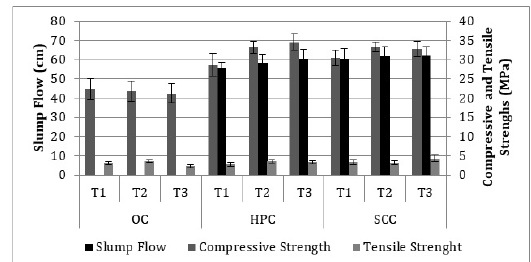
Figure 6. Comparative among slump flow and hardened concrete strengths.